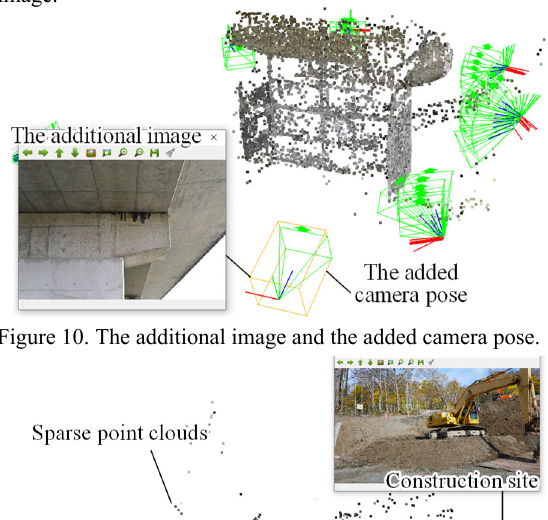
Figure 9. The result of the final textured mesh model generated from MVS; (a) before adding the image and (b) after adding the image.